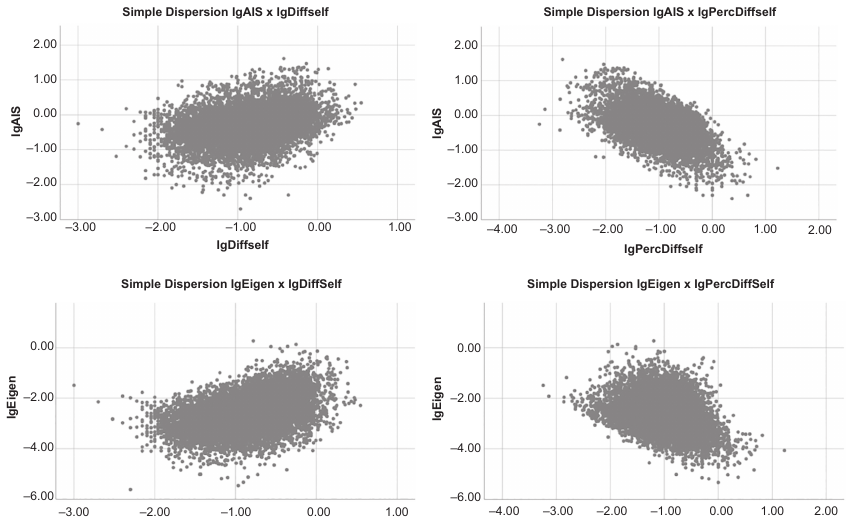
Figure 3. Eigenfactor and AI scores and self- citations (DiffIF: absolute increase in impact factor due to self-citations; PercDiff: Percentual